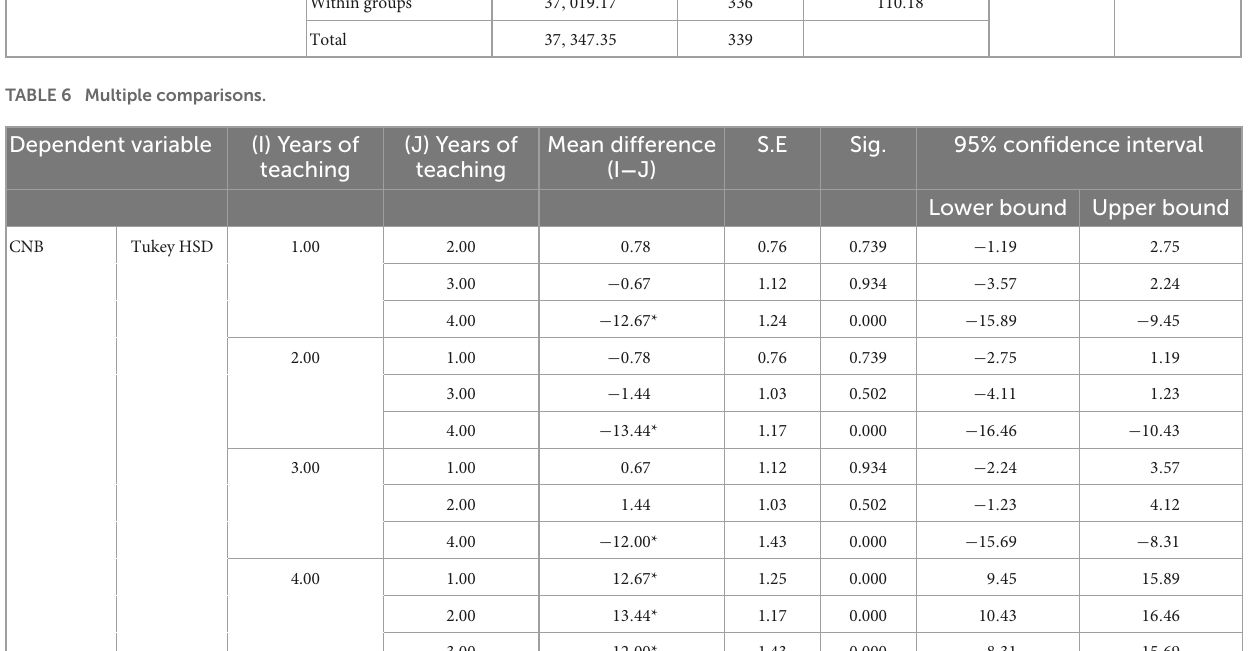
TABLE 6 Multiple